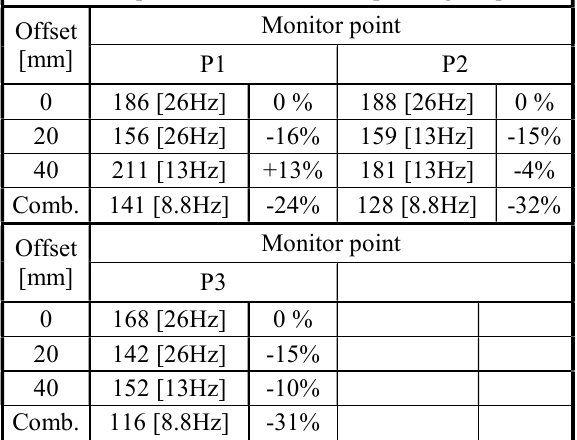
Fig. 14 Amplitude-frequency characteristics calculated from force acting on the stator blade Table 7 The overview of maximum force amplitudes acting on the guide